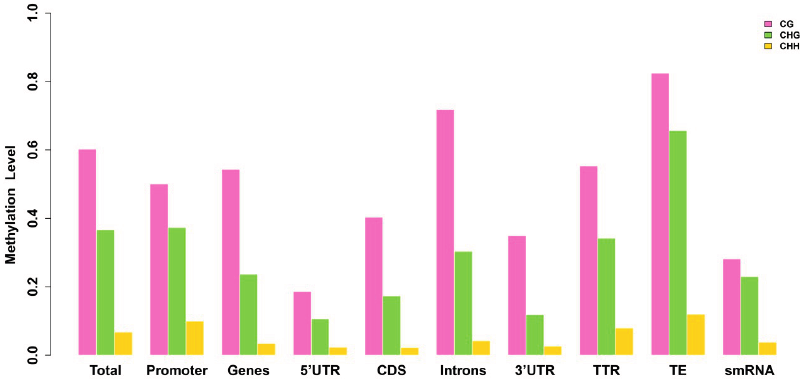
Figure 2. Relative methylation level in each sequence context for different genomic